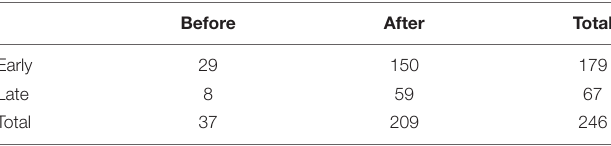
TABLE 5 | Contingency table for double-initiation (both LP and RP) trials, combining the number of times the non-intercepting player reached peak velocity before or after the intercepting participant reached positive angular velocity with the number of times the non-intercepting player abandoned the interception attempt early or late, as determined by the magnitude of the peak velocity